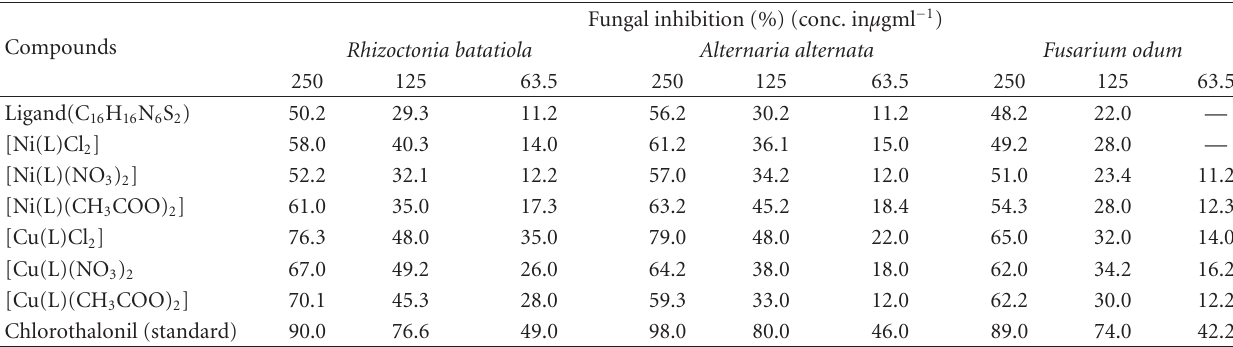
Table 6: Antifungal screening data of the ligand and its Ni(II) and Cu(II)